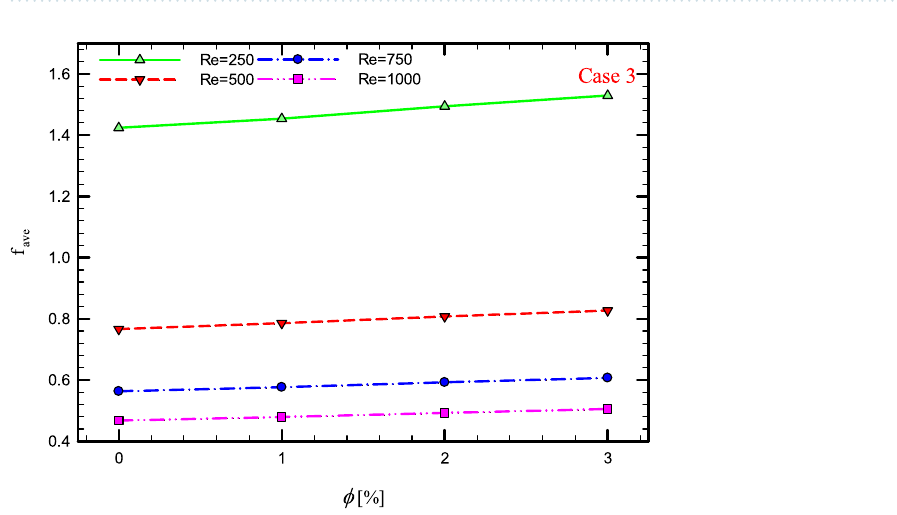
Figure 43. f ave versus φ for Case